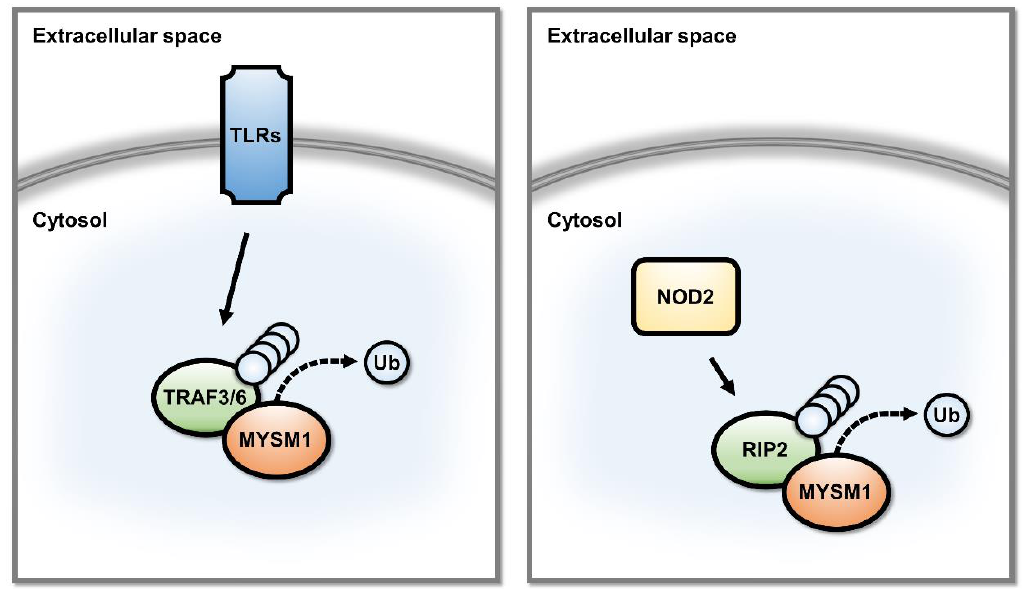
Figure 3. Overview of the cytosolic functions of the MYSM1 protein in the regulation of signal transduction in innate immunity and inflammatory responses in macrophages. MYSM1 was shown to promote deubiquitination of TRAF3, TRAF6, and RIP2 in the signal transduction pathways of TLR and NOD2 pattern recognition receptors, thus, repressing the innate immune and inflammatory responses of macrophages [3,8] .